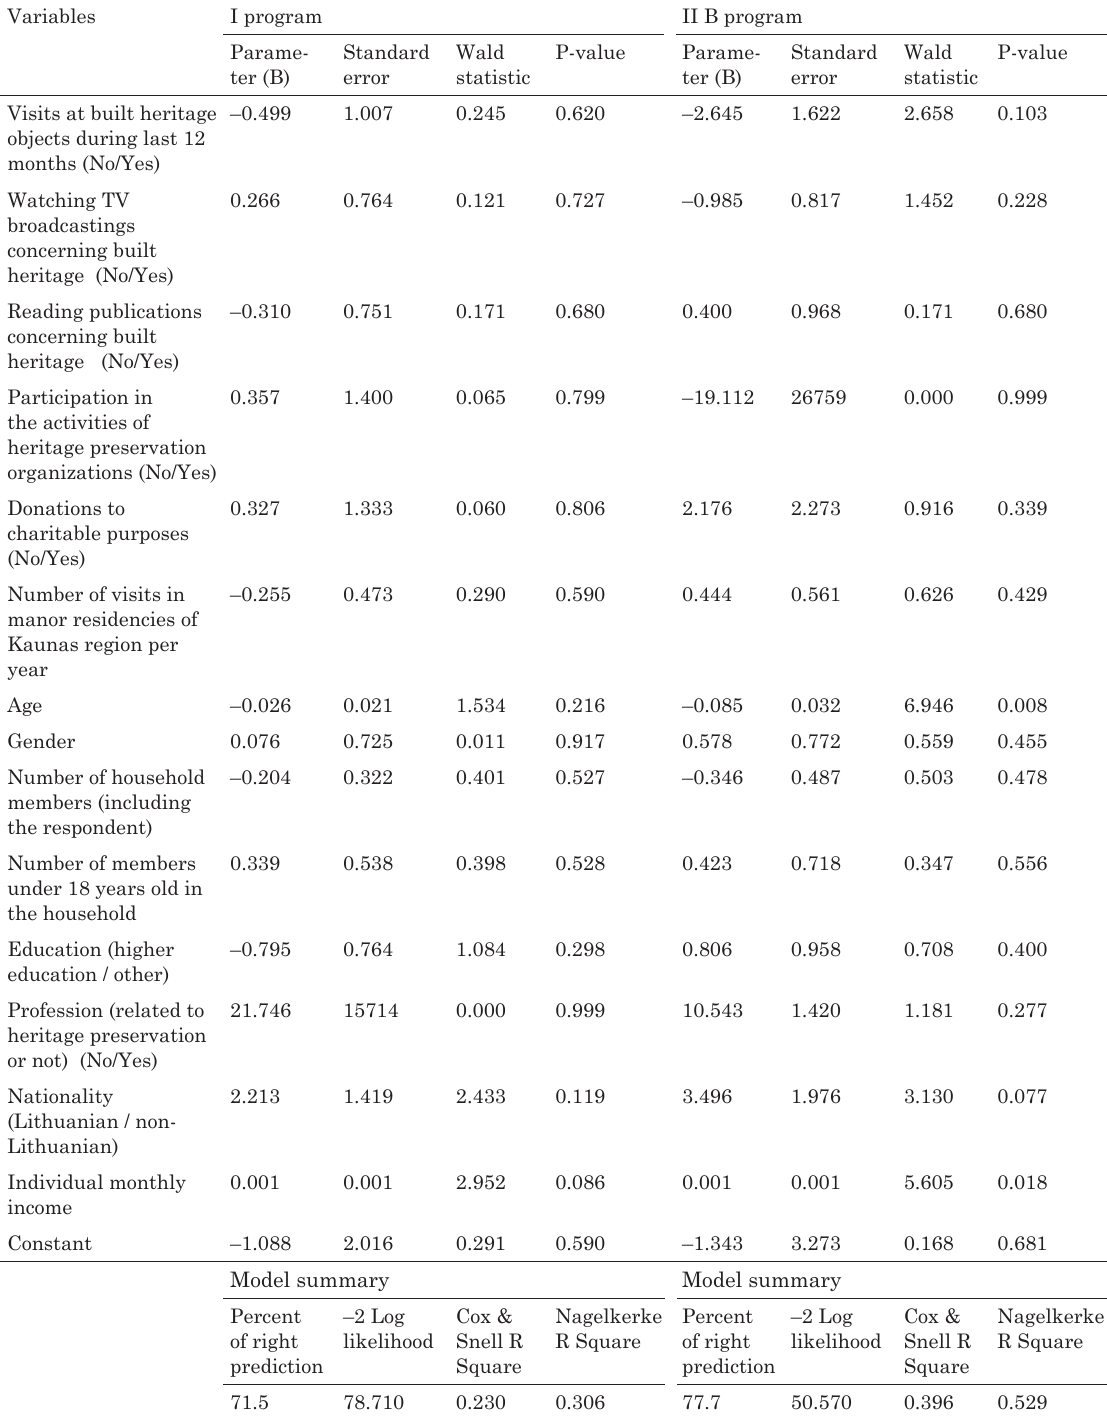
table 3. results of logistic regression